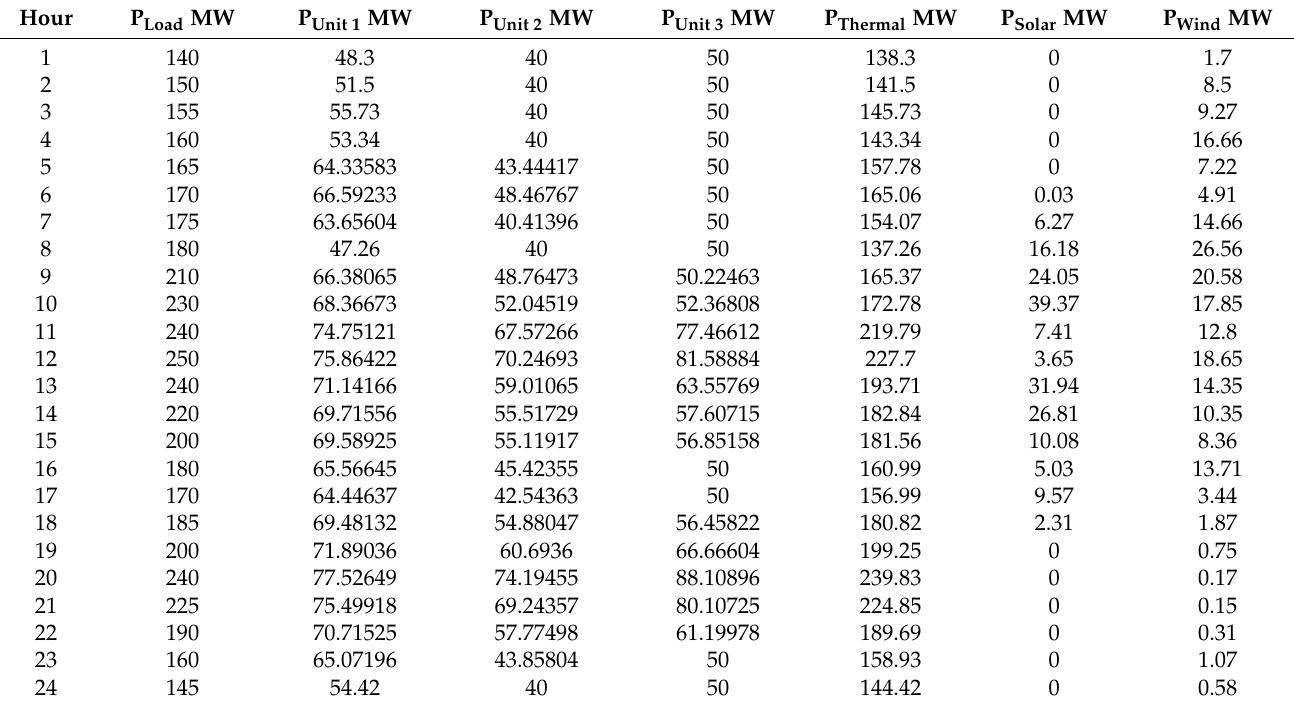
Table 3. Hourly load demand and power generation—case study 1.